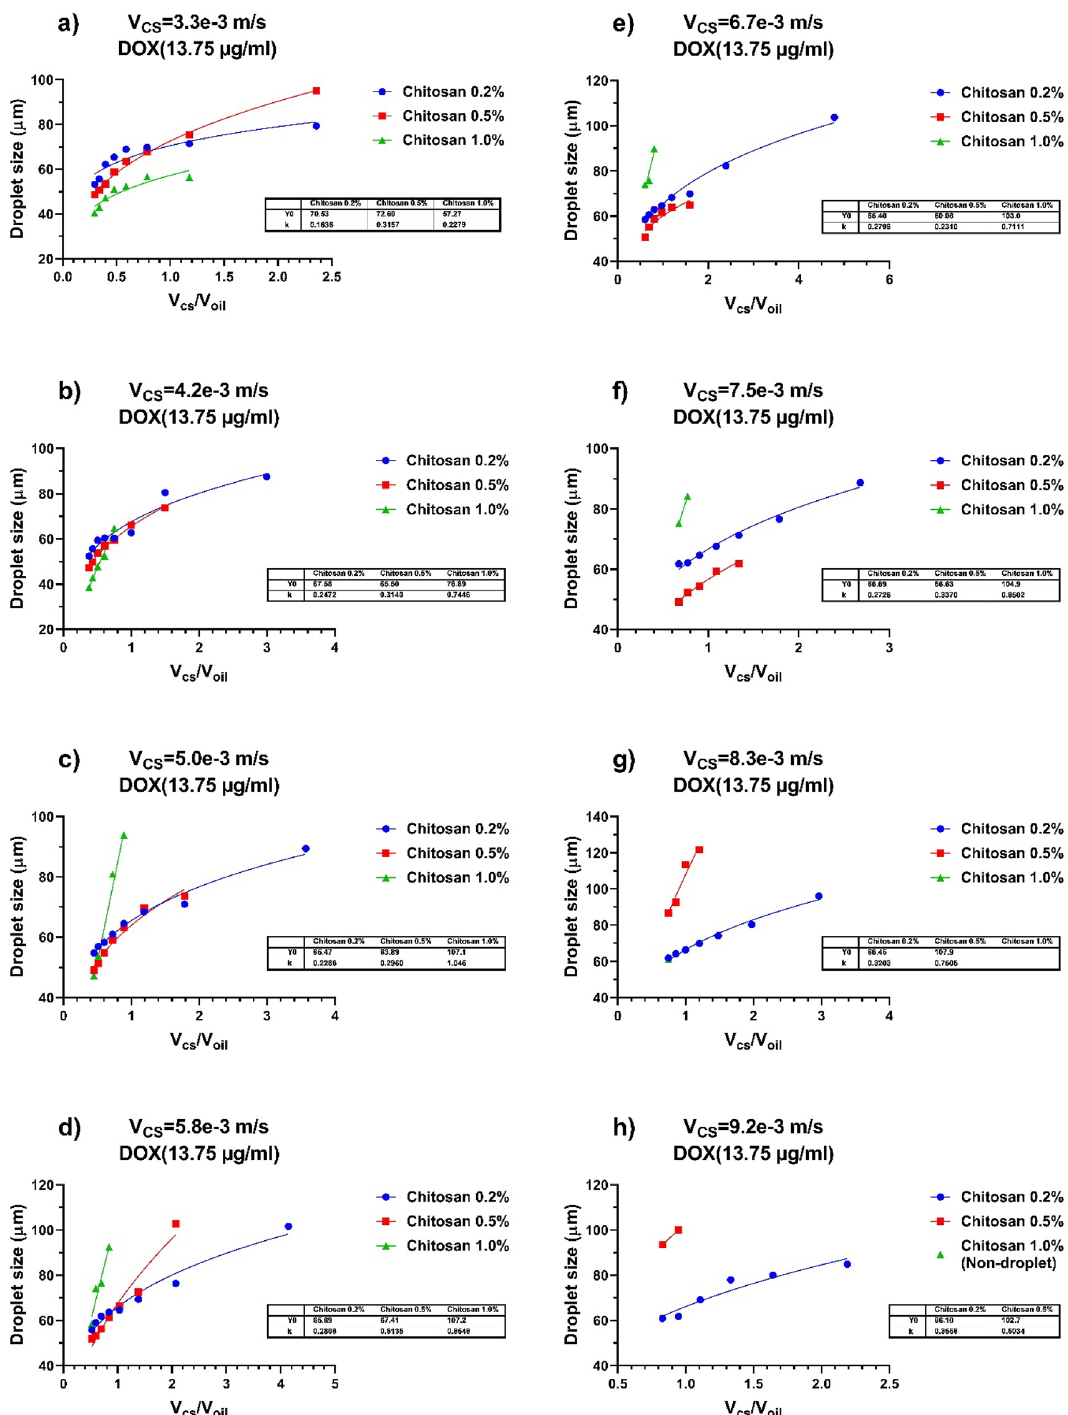
Figure 6. The dependence of the droplet size produced for each of the CS + DOX concentration to the variations of the velocity ratio of the dispersed phase to the continuous phase. The flow rate of vegetable oil and CS + DOX were selected at the limited area of 1.4 to 11.1 and 3.3 to 9.2 mm/s, respectively. The concentrations of CS are 0.2%, 0.5%, and 1.0% (w/v), and also the concentration of DOX is 1.375% (w/v). For each of subfigure, the CS + DOX velocity is fixed and the flow rate of the vegetable oli varies from 1.4 to 11.1 mm/s. The CS + DOX flow rates are ( a ) 3.3 mm/s, ( b ) 4.2 mm/s, ( c ) 5.0 mm/s, ( d ) 5.8 mm/s, ( e ) 6.7 mm/s, ( f ) 7.5 mm/s, ( g ) 8.3 mm/s and ( h ) 9.2 mm/s. As the CS + DOX flow rate increases, some points disappear for each of the three CS + DOX concentrations, indicating that no droplets are formed at this concentration and velocity ratio of the dispersed phase to the continuous phase. Continuous lines are curves plotted on experimental data using the power equation (Y = Y 0 * X k ). The values of Y 0 and K of each of these curves are shown in the table in each